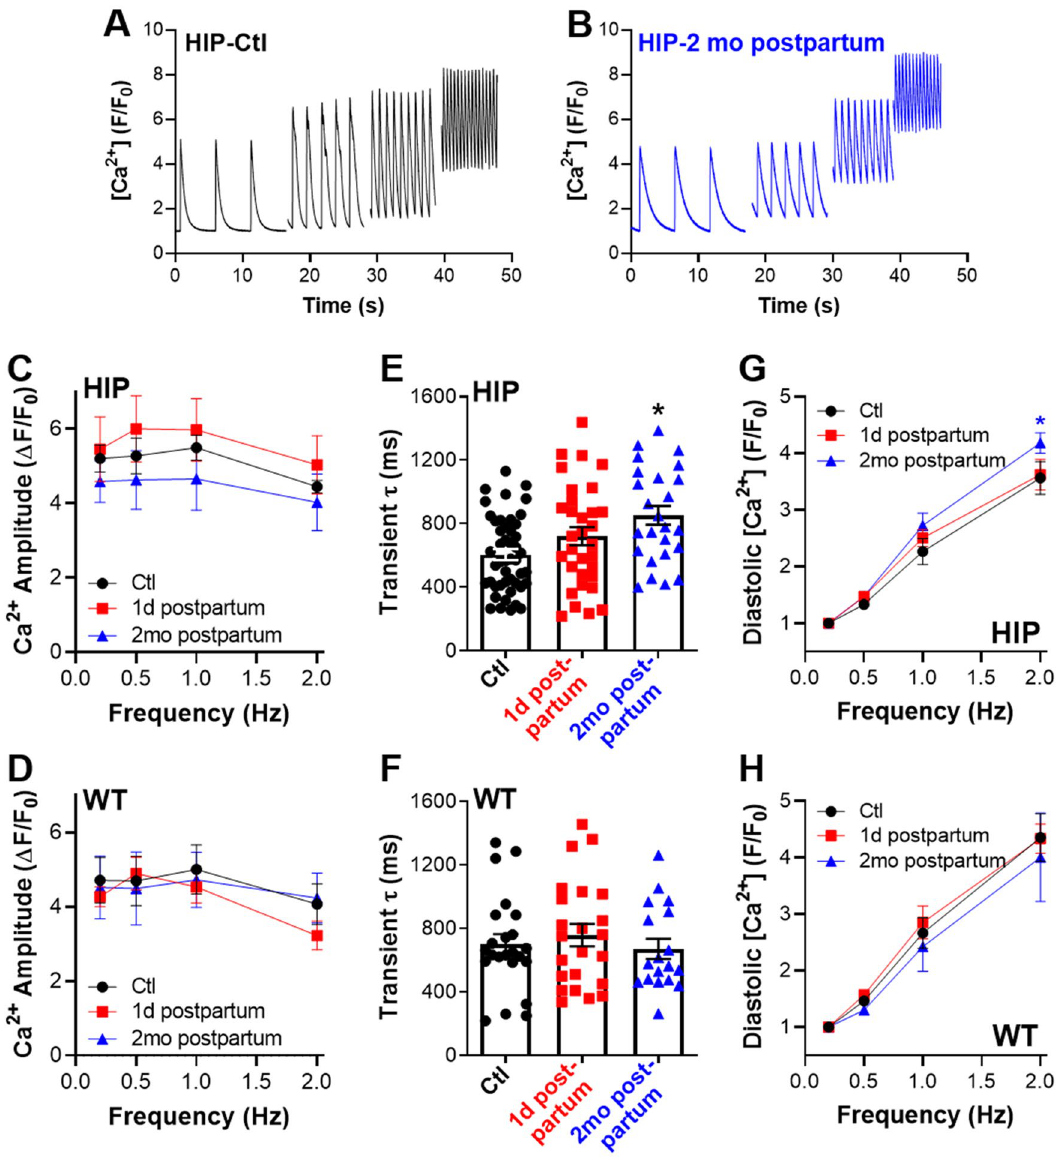
Figure 4. Ca 2+ transients in myocytes from control (Ctl), 1 day and 2 months postpartum females. ( A , B ) Representative examples of Ca 2+ transients stimulated at 0.2, 0.5, 1 and 2 Hz in myocytes from control, non- pregnant HIP females ( A ) and two months postpartum HIP females ( B ). ( C,D ) Ca 2+ transient amplitude in myocytes from HIP ( C ) and WT ( D ) females. ( E,F ) Decay time of Ca 2+ transients triggered by pacing at 0.5 Hz in myocytes from HIP ( E ) and WT ( F ) females. ( G,H ) Diastolic Ca 2+ as a function of stimulation frequency in myocytes from HIP ( G ) and WT ( H ) females. Measurements were done in females from control (WT: 6 females, 3-4cells/rat; HIP: 9 females, 3–7 cells/rat), 1 day postpartum (WT: 6 rats, 3–6 cells/rat; HIP: 8 rats, 2–6 cells/rat) and 2 months postpartum (WT: 3 rats, 6 cells/rat; HIP: 5 rats, 3–7 cells/rat) groups. The number of cells per each rat is shown in Supplementary Table 2. Data for animals in control groups sacrificed at the time when pregnancy groups were at 1 day and 2 months postpartum were pooled. Statistical analysis was performed with Two-way ANOVA for panels C, D, G and H, and with a mixed model using the Nested One-Way ANOVA analysis in Prism 8.1.2 for panels E and F. Dunnett’s post-test was used to account for multiple overload-induced heart growth. However, one study reported increased thickness of the septal and posterior walls with no change in diastolic diameter in pregnant women 16 , while an investigation in pregnant mice found hypertrophy characterized by decreased left-ventricular wall thickness and larger chamber size 19 . Somewhat surprisingly, pregnant WT females did not show overt cardiac remodeling or hypertrophy in our study. The reasons for this are unclear but might reflect reduced ability of the heart to undergo physiological hypertro- phy due to a more advanced age (~ 5.5 months of age). This is in line with studies reporting lack of exercise- induced hypertrophy in aged animals 45,46 . In contrast, our data suggest that GDM is associated with concentric